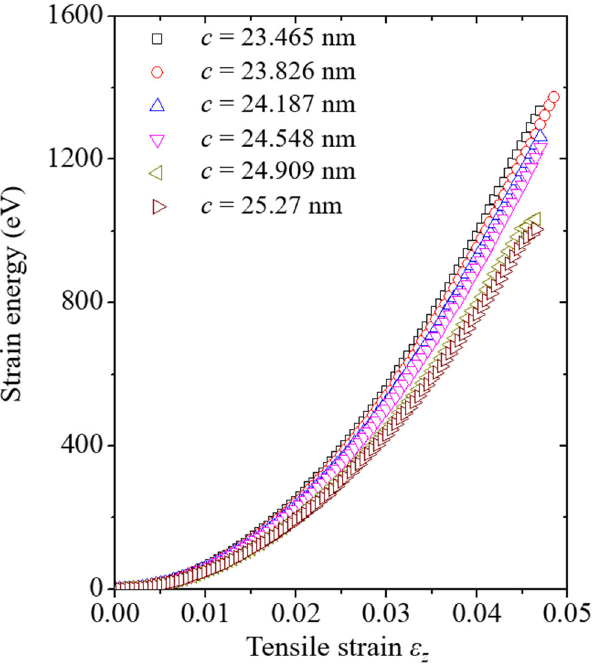
Figure 6. Strain energy of the (4,4) CNT model with various crack lengths corresponding to the tensile strain. c denotes the crack length in the model.